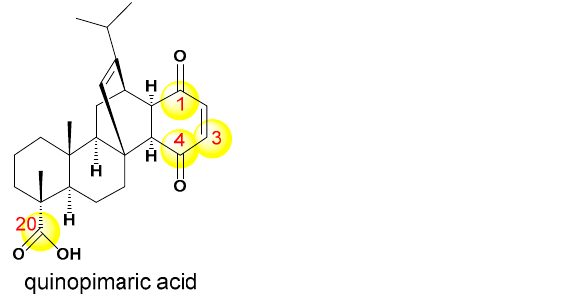
Figure 1. Quinopimaric acid reaction centers for the SAR studies of the current research. Modifications of these sites involved the synthesis of arylidene and heterocyclic derivatives and quinopimaric acid cyanoetoxy- and propargylated analogs. Figure 2 shows the structures of quinopimaric acid 1 and its analogs 2 – 30 , modified at position C-1, C-3, C-4, and C-20.